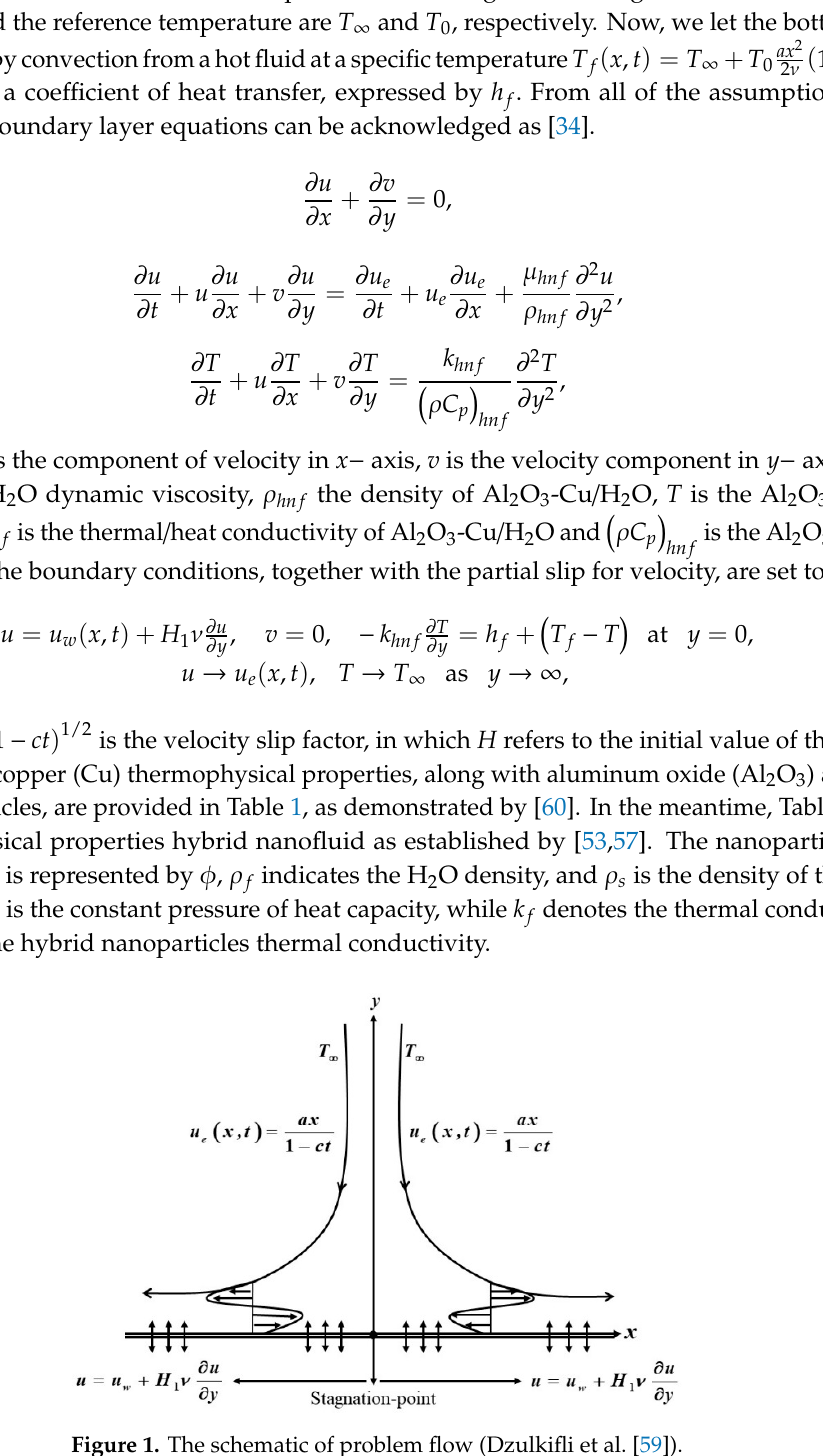
Figure 1. The schematic of problem flow (Dzulkifli et al. [59]).